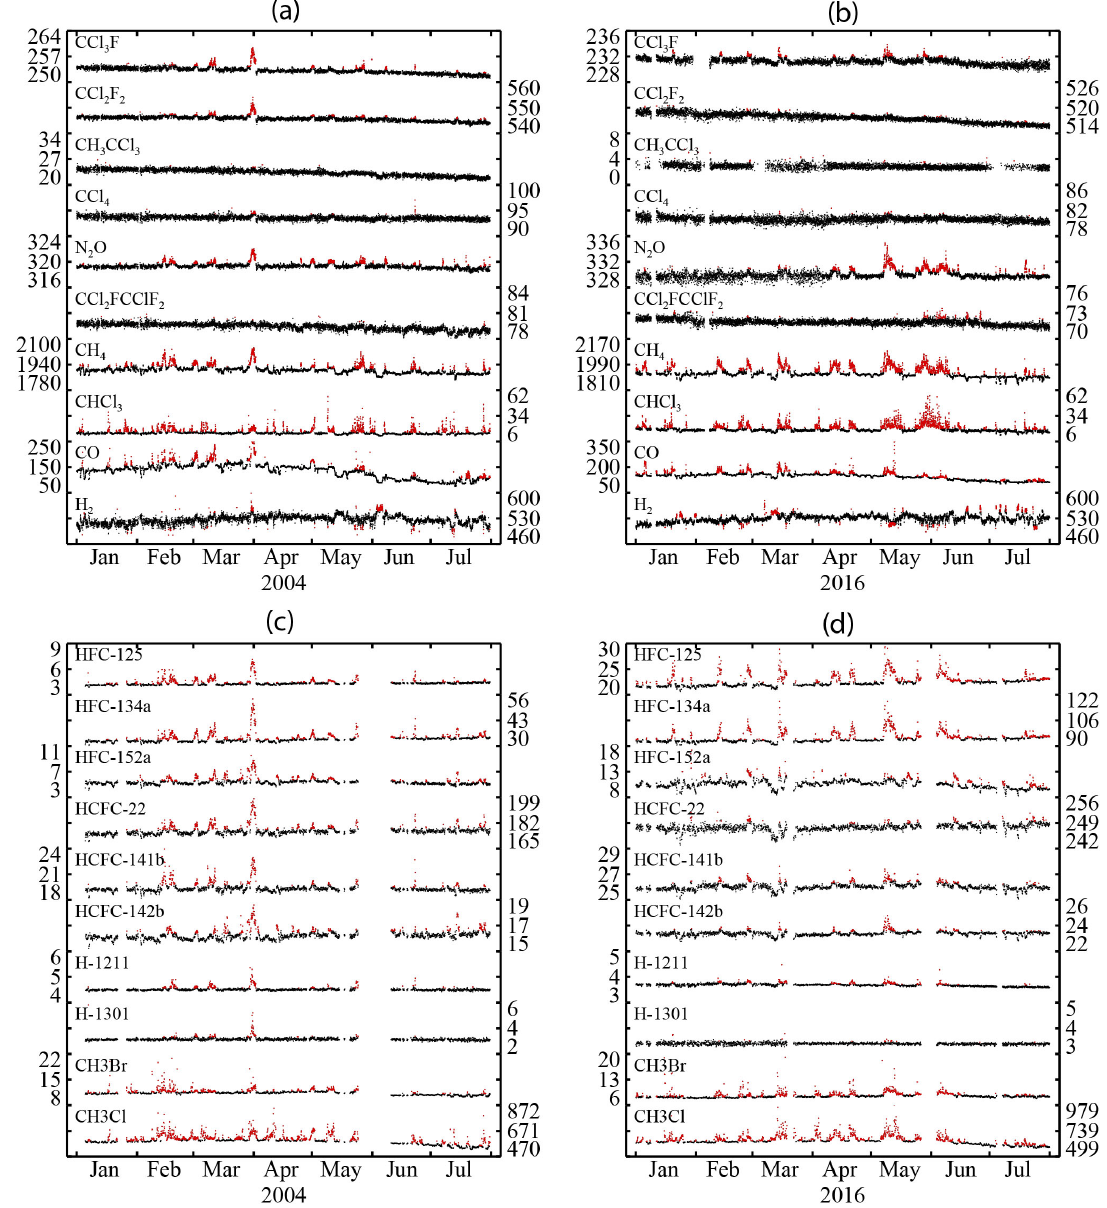
Figure 2. A total of 7 months of data for gases measured at Mace Head, Ireland: (1) with the GC-MD in (a) 2004 and (b) 2016 (units: mole fractions; ppb for N 2 O, CH 4 , H 2 , and CO; ppt for all others) and (2) with the Medusa GC-MS for selected gases in (c) 2004 and (d) 2016 (units: mole fractions in ppt for all gases). In all four panels, measurements in polluted air originating from Europe (also in air affected by local sinks; see text) are shown in red, while those in clean air off the Atlantic Ocean are shown in black. Note that pollution events are defined separately for each gas due to their often differing